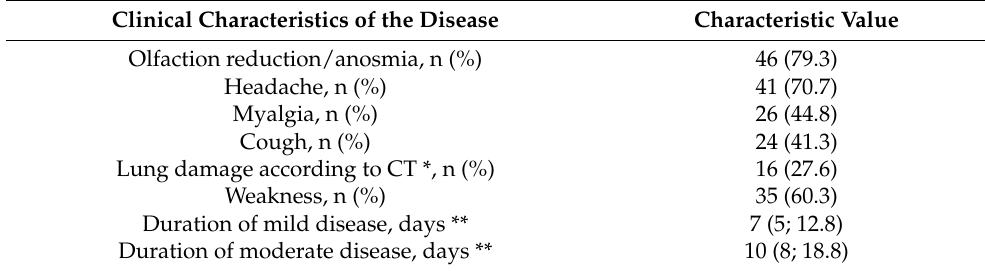
Table 2. Clinical characteristics of the course of the disease in COVID-19-recovered individuals (n = 58). Clinical Characteristics of the